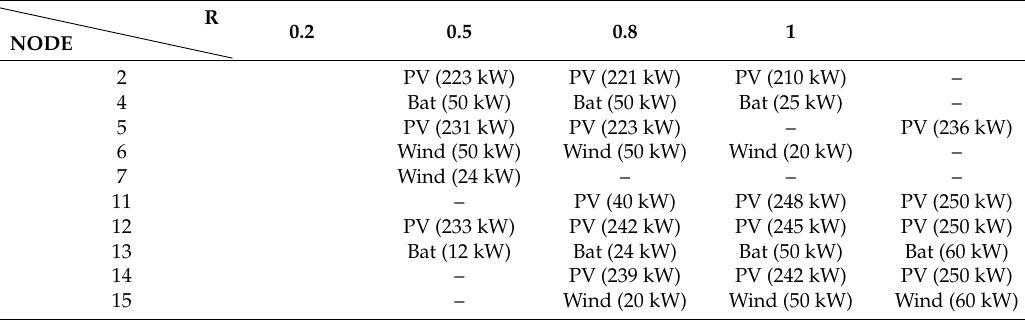
Table 2. Case I distributed power capacity and site optimization planning (type